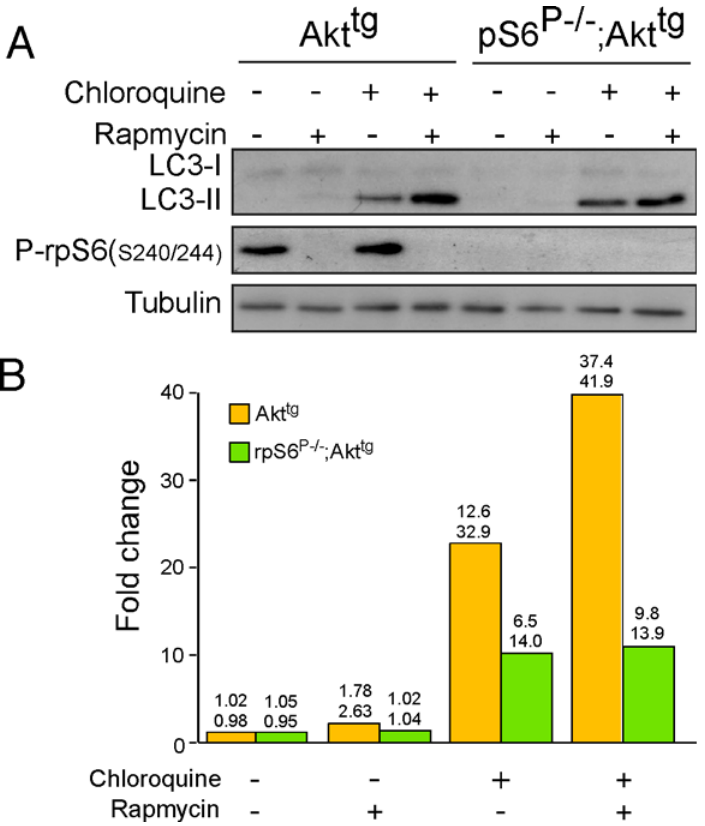
Fig 7. The phosphorylation status of rpS6 plays no role in autophagy. (A) Immortalized Akt tg and rpS6 P-/- ;Akt tg , MEFs were either untreated, incubated with 20 nM rapamycin, 50 μ M chloroquine or both for 16 h. Cells were harvested and their cytoplasmic proteins were subjected to Western blot analysis with the indicated antibodies. (B) The signals of LC3-II, obtained in Western blot analyses of two independent experiments, as described in (A), were quantified and normalized to that tubulin. The fold change in the expression of LC3-II upon addition of rapamycin, chloroquine or both, was related to that of untreated cells, which was arbitrarily set at